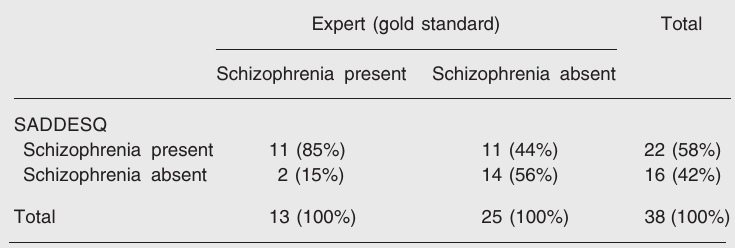
Table 2. Comparison of the diagnoses resulting from the analysis of 38 vignettes between the SADDESQ and the expert when schizophreniform disorder was consid- ered to correspond to the absence of